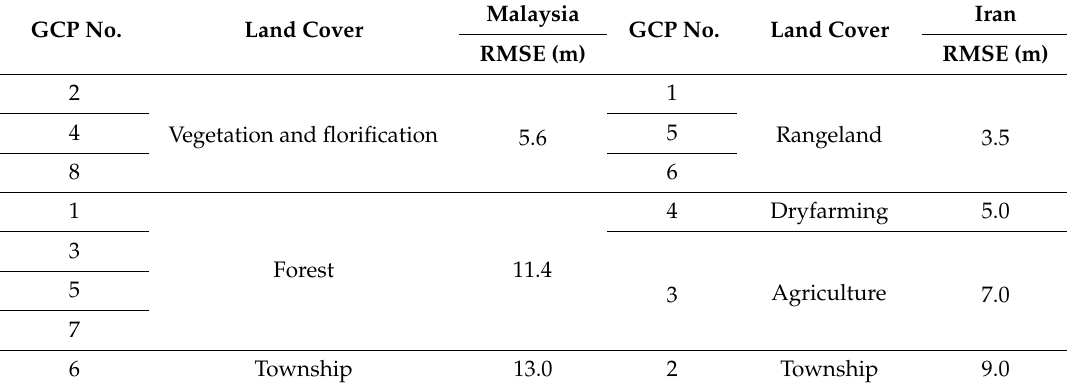
Table 6. The Root Mean Square Error (RMSE) of Sentinel-1 DEM based on the GCPs for the study areas. GCP